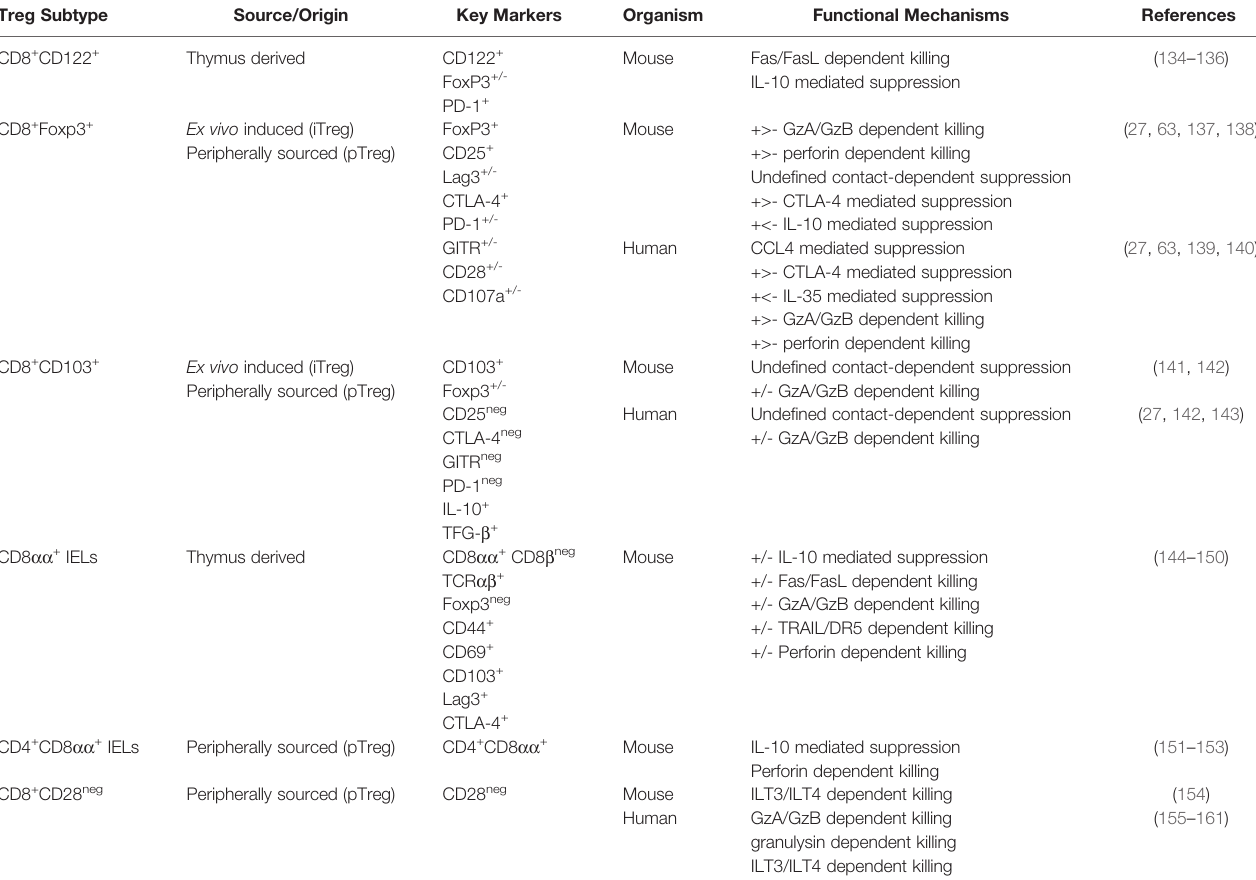
TABLE 2 | Immunosuppressive and cytotoxic killing mechanisms used by CD8 + Treg